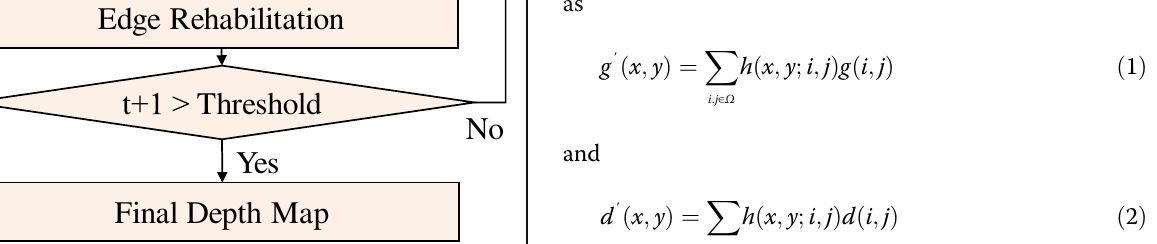
Fig. 3 Flow chart of rotating counsel refinement